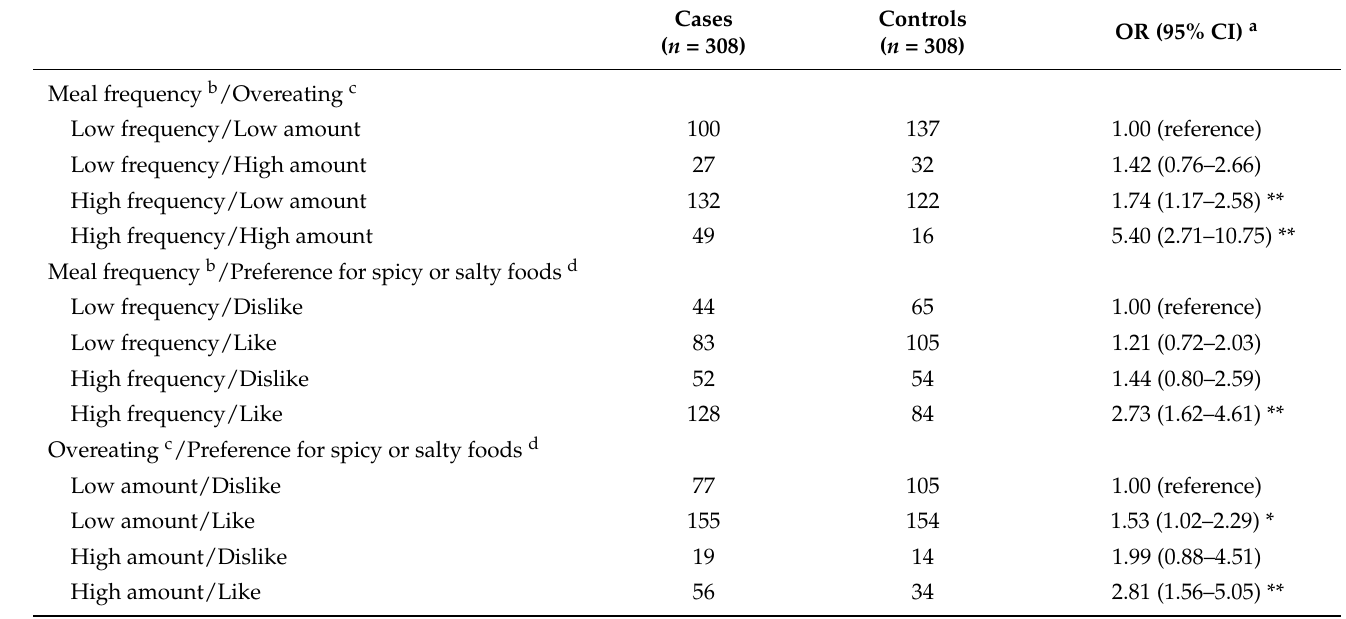
Table 4. Odds ratios (ORs) and 95% confidence intervals (95% CIs) of gastric cancer by combinations of dietary factors irritating the stomach